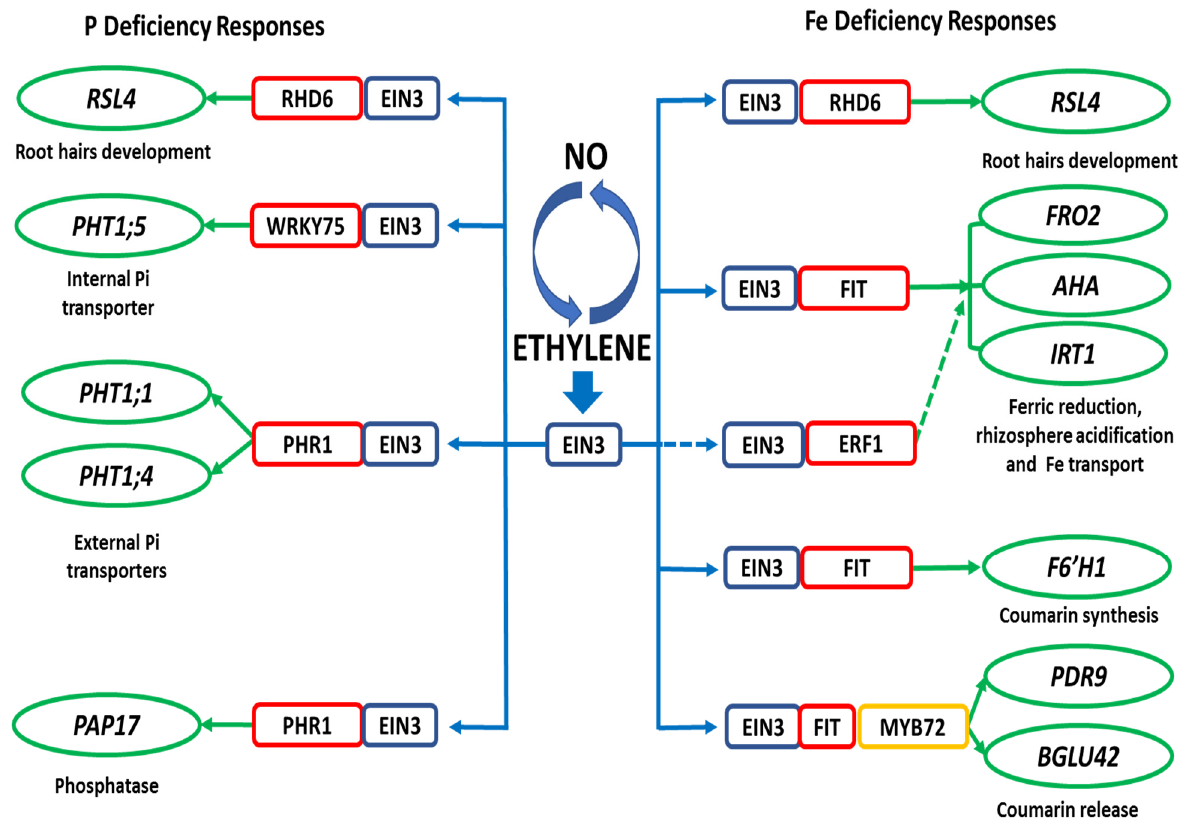
Figure 1. Working model proposed to explain the regulation of P and Fe deficiency responses by ET through EIN3. EIN3 (also EIL1) interacts with the PHR1 and WRKY75 TFs to regulate some P deficiency responses, such as expression of the internal ( PHT1;5 ) and external ( PHT1;1 and PHT1;4 ) Pi transporters, and PAP17 (acid phosphatase). EIN3 (also EIL1) interacts with the FIT TF to regulate some Fe deficiency responses, such as expression of FRO2 (ferric reductase), IRT1 (Fe transporter), F6´H1 , BGLU42 and PDR9 (genes related to coumarin synthesis and release; these latter ones activated through the MYB72 TF). EIN3 can also interact with the ERF1 TF to regulate FRO2 and IRT1 expression. Finally, EIN3 can also interact with RHD6 to modify the expression of RSL4 and promotes root hair elongation either under P deficiency or Fe deficiency. Based on [33,40,41,46,69,96,99,131,135–137].